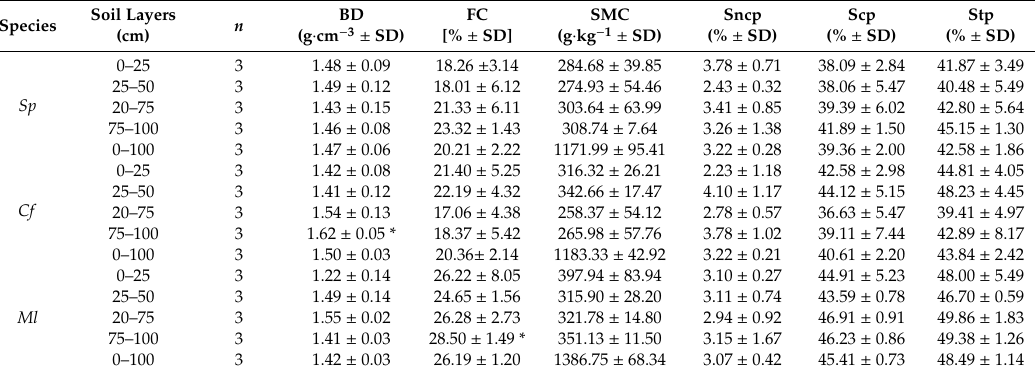
Table 1. Measured soil physical properties including bulk density (BD, g · cm − 3 ), field capacity (FC, %), saturation moisture content (SMC, g · kg − 1 ), soil non-capillary porosity (Sncp, %), soil capillary porosity (Scp, %) and soil total porosity (Stp, %) in 0–25, 25–50, 50–75, 75–100 and 0–100 cm layers. The symbol ‘*’ indicates significant di ff erences ( p < 0.05) between di ff erent tree species in the same layers. Species